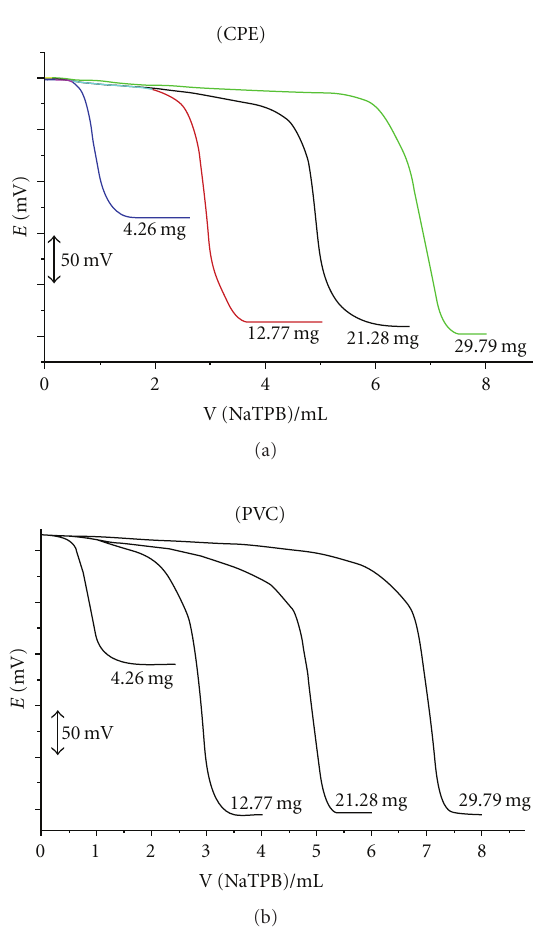
Figure 5: Potentiometric titration of KTF against 10 − 2 molL − 1 NaTPB using CPE and PVC membrane